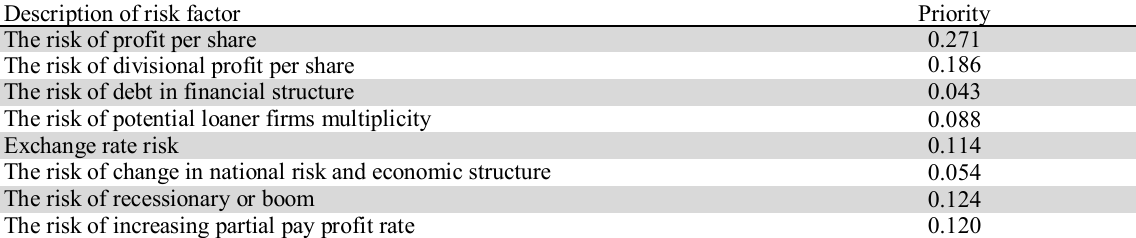
The summary of risk associated with financing expenses